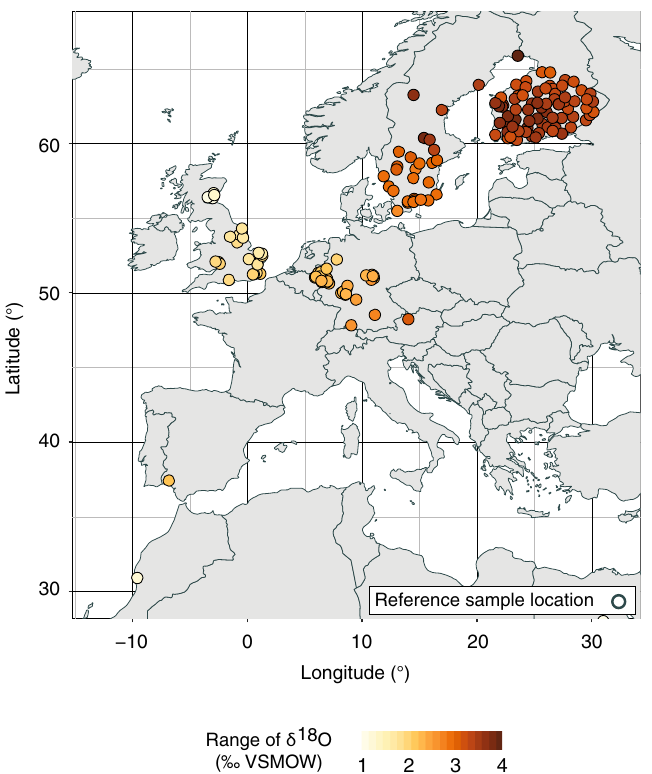
Figure 4. Map of Europe, showing locations where authentic reference samples were collected, and the range of predicted strawberry bulk dried tissue δ 18 O values at each location for all growing season months (May to July), and years over which the sample set was collected (2007–2017). Predictions were made using the best berry- specific model (see text). The map was created using the software R, version 3.5.3 (https:// www.r- proje ct.